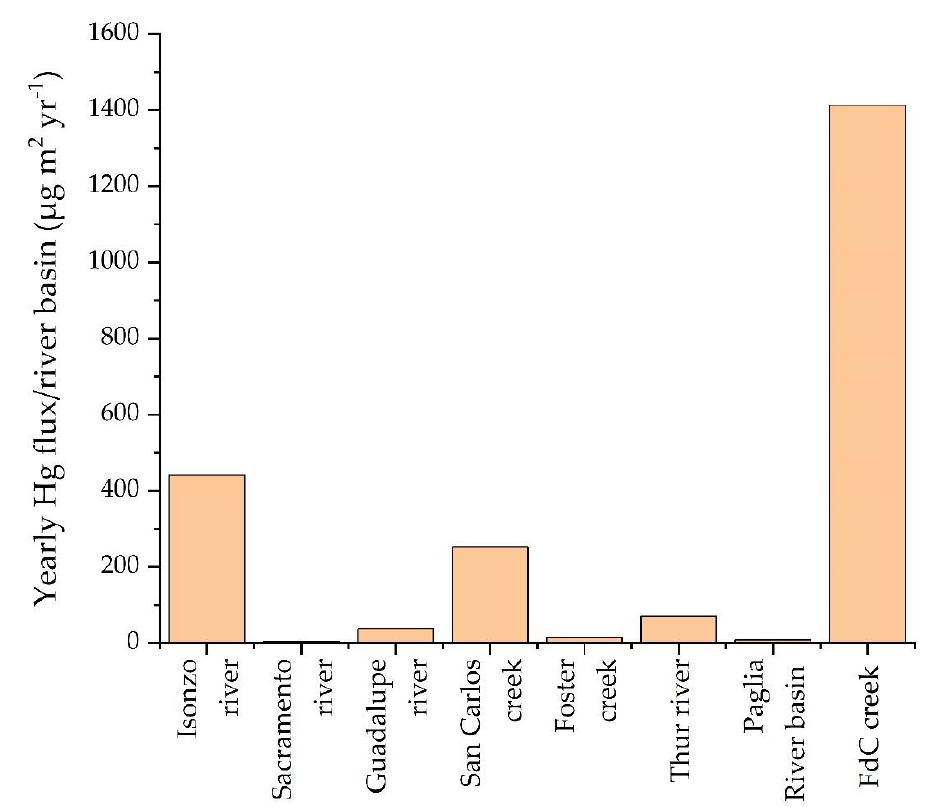
Figure 6. Bar diagram of the specific mass load from different active and abandoned mining localities in comparison with that computed for FdC.